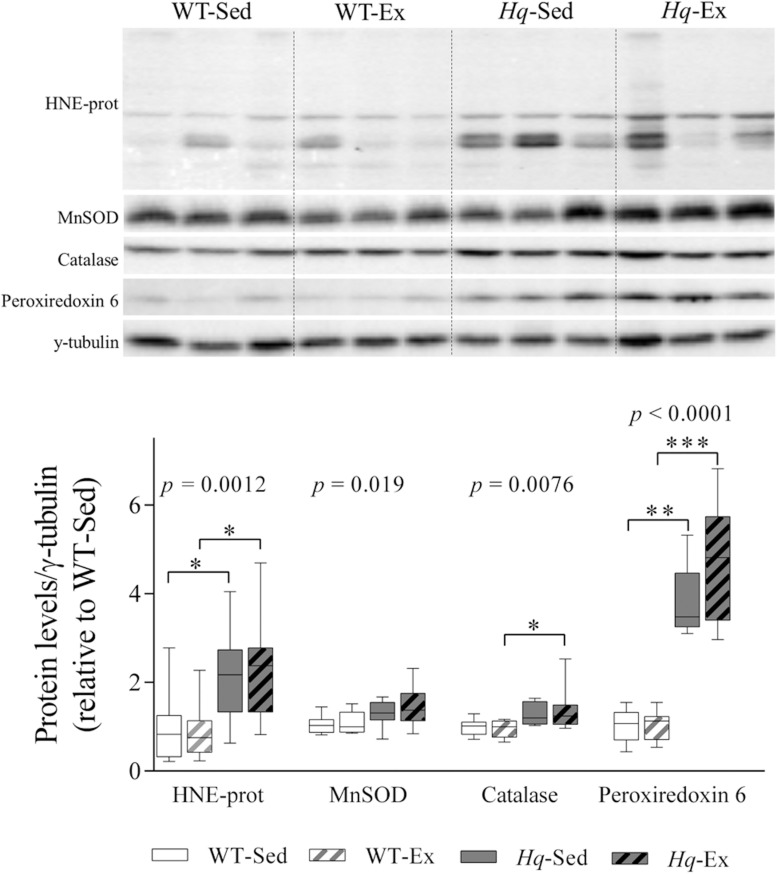
Oxidative stress marker and antioxidant enzymes. Western blot analysis of 4-hydroxynonenal-modified proteins (HNE-prot), manganese superoxide dismutase (MnSOD), catalase and peroxiredoxin 6, in cerebellum homogenates of wild-type sedentary (WT-Sed, n = 12) and exercise-trained (WT-Ex, n = 11) mice, and of Hq sedentary (Hq-Sed, n = 11) and exercise-trained (Hq-Ex, n = 10) mice. Densitometry analysis: protein levels were normalized to γ-tubulin levels; data (median, interquartile range, and min and max values) are expressed relative to levels in the WT-Sed group. Significant p-values for the group effect (Kruskal-Wallis test) are shown above the corresponding boxes. Symbols for significant differences in post hoc pairwise comparisons: ∗p < 0.05; ∗∗p < 0.01; ∗∗∗p < 0.001 for Hq-Sed vs. WT-Sed, and Hq-Ex vs. WT-Ex.